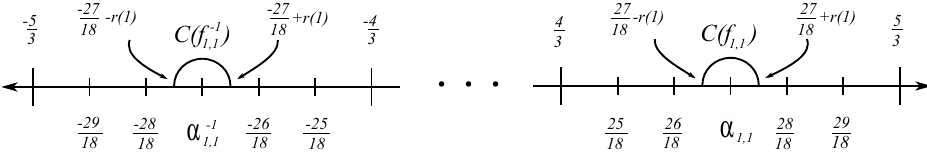
Figure 11: The closed intervals ˆ I 1,1 and −ˆ I 1,1 are divided into six closed subintervals.